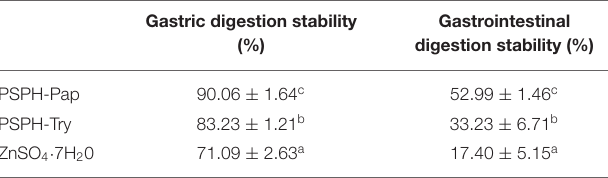
TABLE 2 | The in vitro gastrointestinal stability of PAPH-Pap, PSPH-Try, and ZnSO 4 · 7H 2 O. Gastric digestion stability